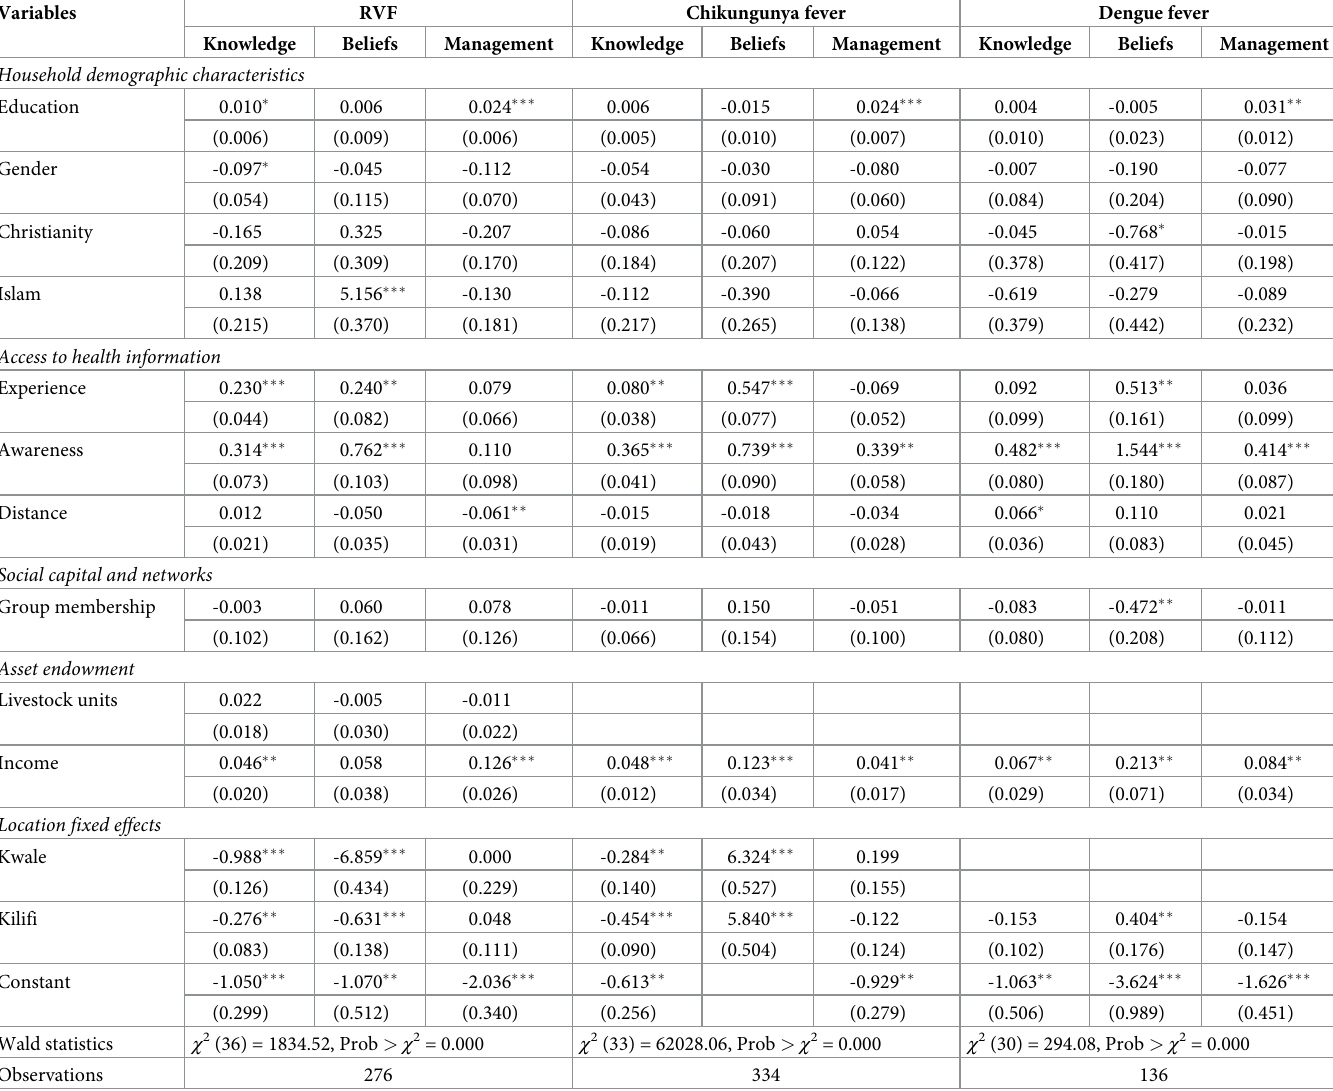
Table 5. Multivariate fractional probit maximum likelihood estimates of the intensity of farmers KBM of ADs in Kenya. Variables